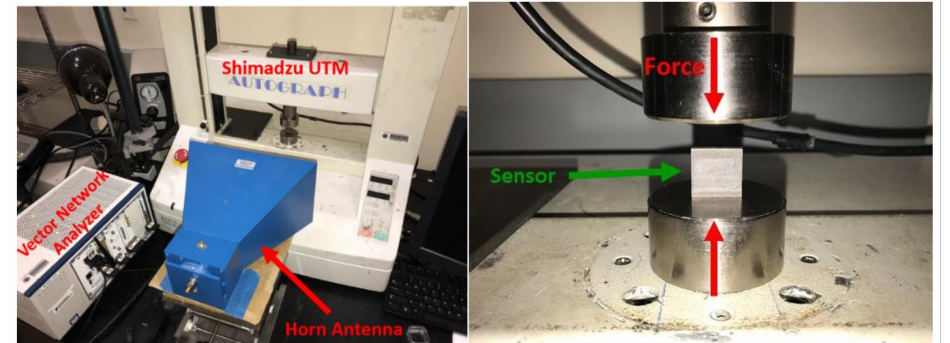
Figure 14. Pressure sensor experimental